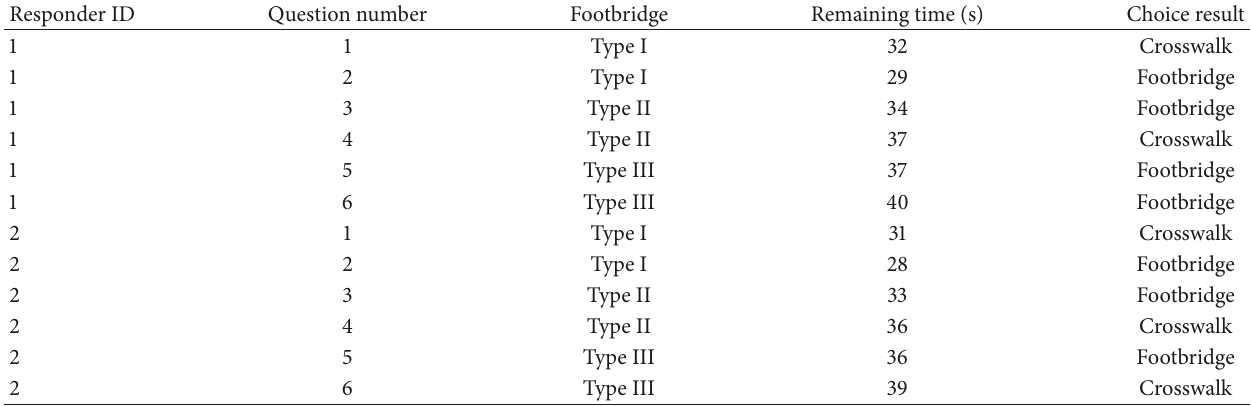
Table 1: An example of survey